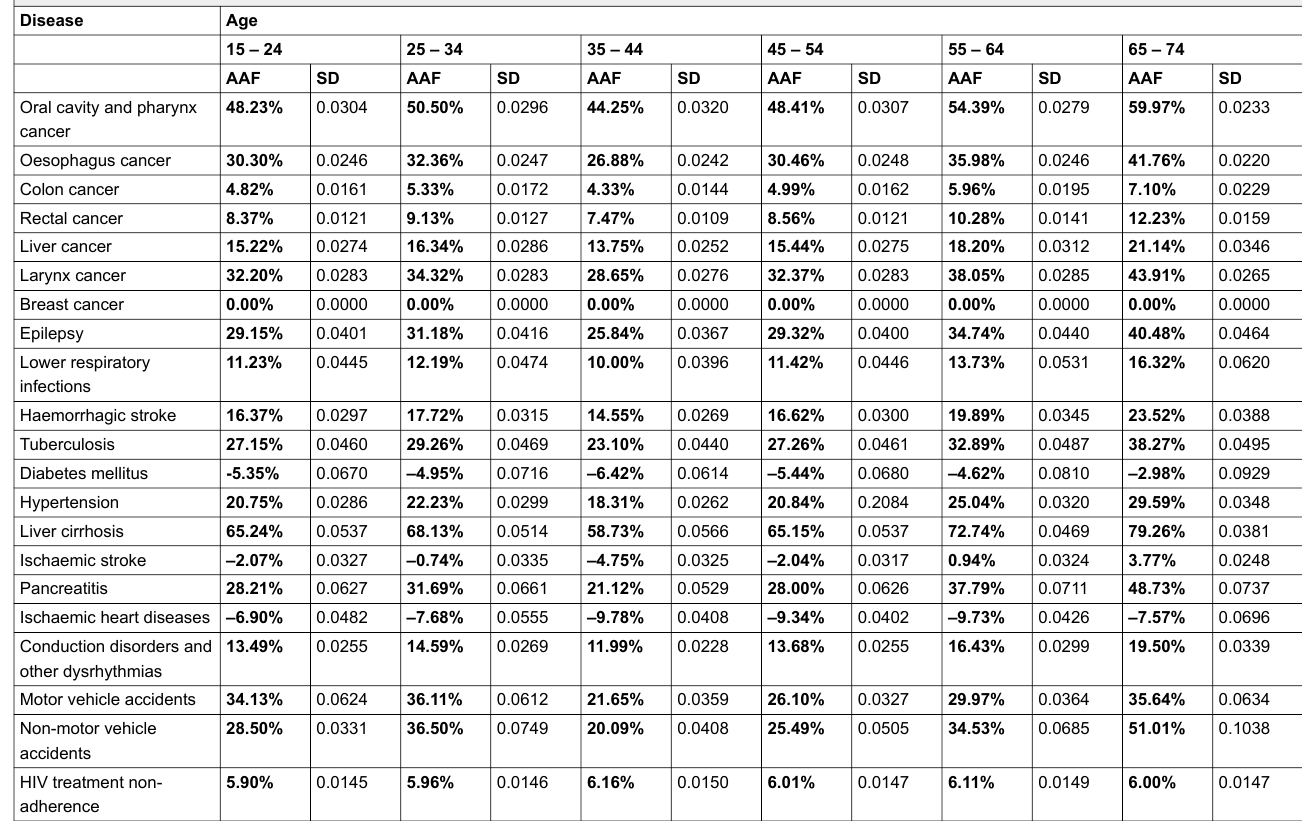
Table A3: Alcohol-attributable fractions, men 2011